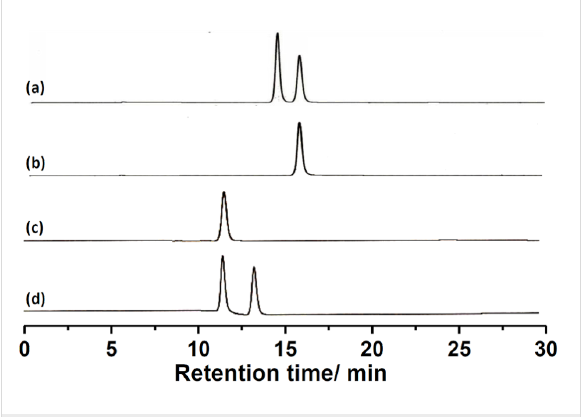
Figure 2: Chromatogram (Chiral HPLC) obtained for (a) racemic mix- ture of ( E )- 1 (b) sample used for reductive debromination (second eluted enantiomer S-( − )-( E )- 1) (c) recorded after the LiAlH 4 reduction of S-( − )-( E )- 1 and (d) the chromatogram of racemic ( E )- 2 . (Column: Chiralpak IA, eluent: ethyl acetate/hexane (10:90), Flow rate: 3 mL/min)